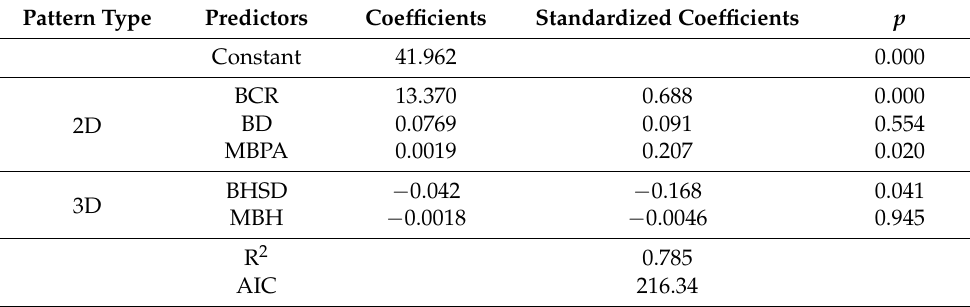
Table 5. The results of the spatial error